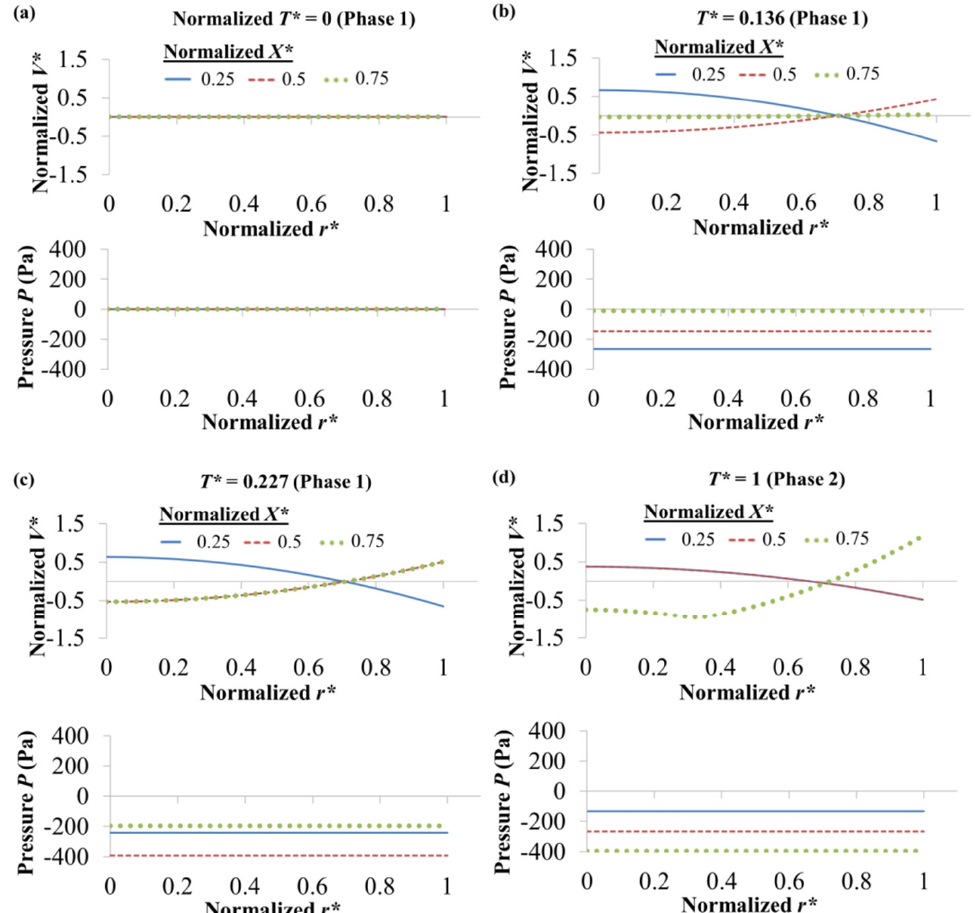
Figure 7. Numerically simulated normalized velocity V* and pressure P along normalized radial r* for normalized X* = 0.25, 0.5 and 0.75 of 0.5 mM NaCl → 0.5 mM NaHCO 3 (arrow indicates EOF direction) in ( a ) Phase 1 T* = 0, ( b ) Phase 1 T* = 0.136, ( c ) Phase 1 T* = 0.227 and ( d ) Phase 2 T* = 1. Normalized V* = ( V − V Avg )/ V Avg . Average velocity V Avg = Q / A L = Q /( π R 2 ), where Q is flow rate obtained by integrating radial velocity over microchannel cross sectional area A L , and R is channel radius. Normalized r* = r / R . Normalized time T* = T / T SS NaCl → NaHCO 3 , where T SS NaCl → NaHCO 3 is time to reach steady-state current for NaCl → NaHCO 3 . Normalized X*= X / L , where X is axial coordinate and L channel length.